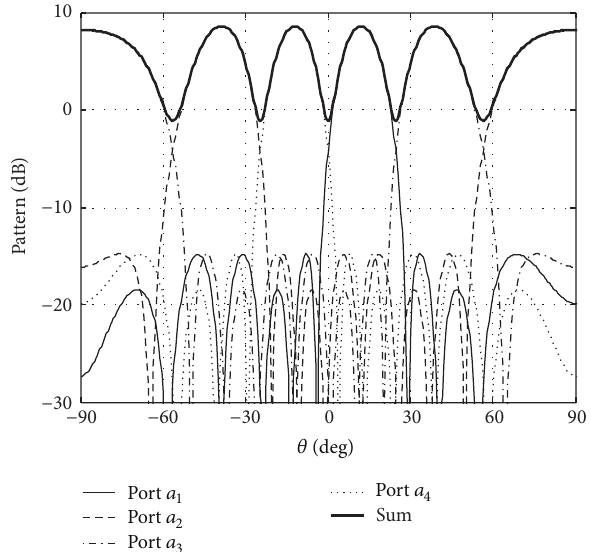
Figure 9: Radiation patterns produced by the loaded ports of the considered 4 × 8 Nolen matrix with tapered amplitude